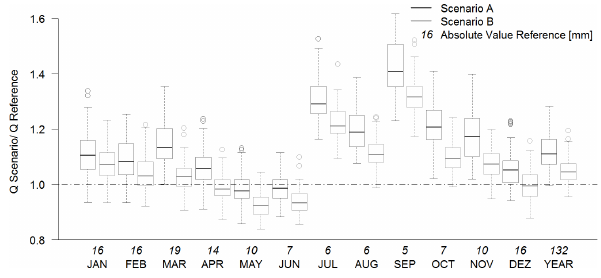
Fig. 6. Ratio between discharge ( Q ) of the scenarios and the refer- ence period, Weisser